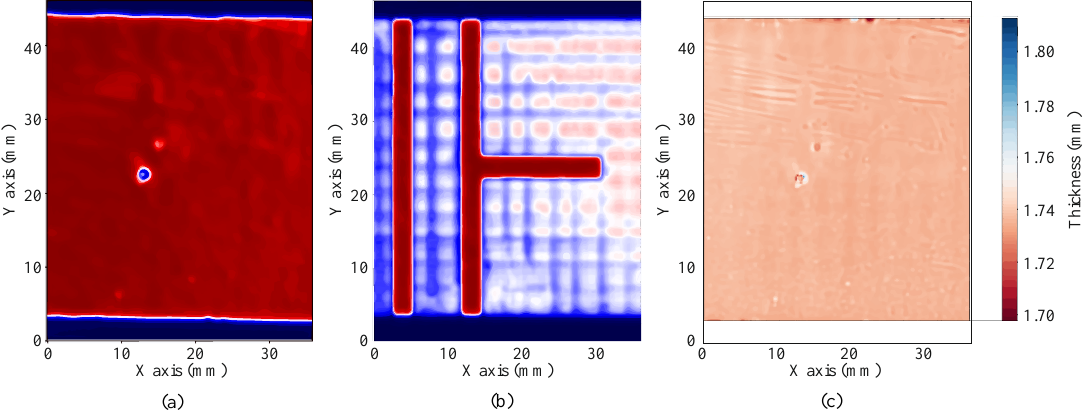
Figure 7. Examples of C-scan for ( a ) bottom surface, ( b ) top surface and ( c ) thickness map.